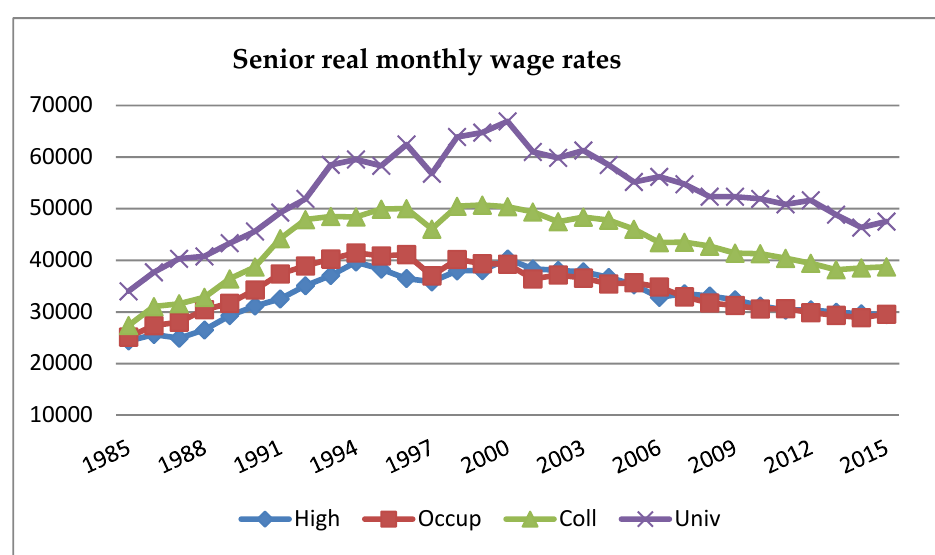
Figure 4. Senior real monthly wage rates. Source: same as Figure 1 .